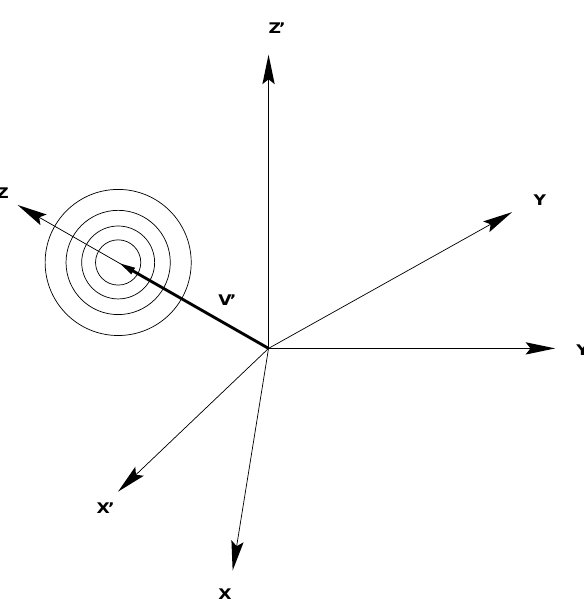
Fig. 1. Sketch of the measurement (or spacecraft) frame (X 0 ,Y 0 ,Z 0 ) and computation frame (X,Y,Z) . The Maxwellian drift velocity is V 0